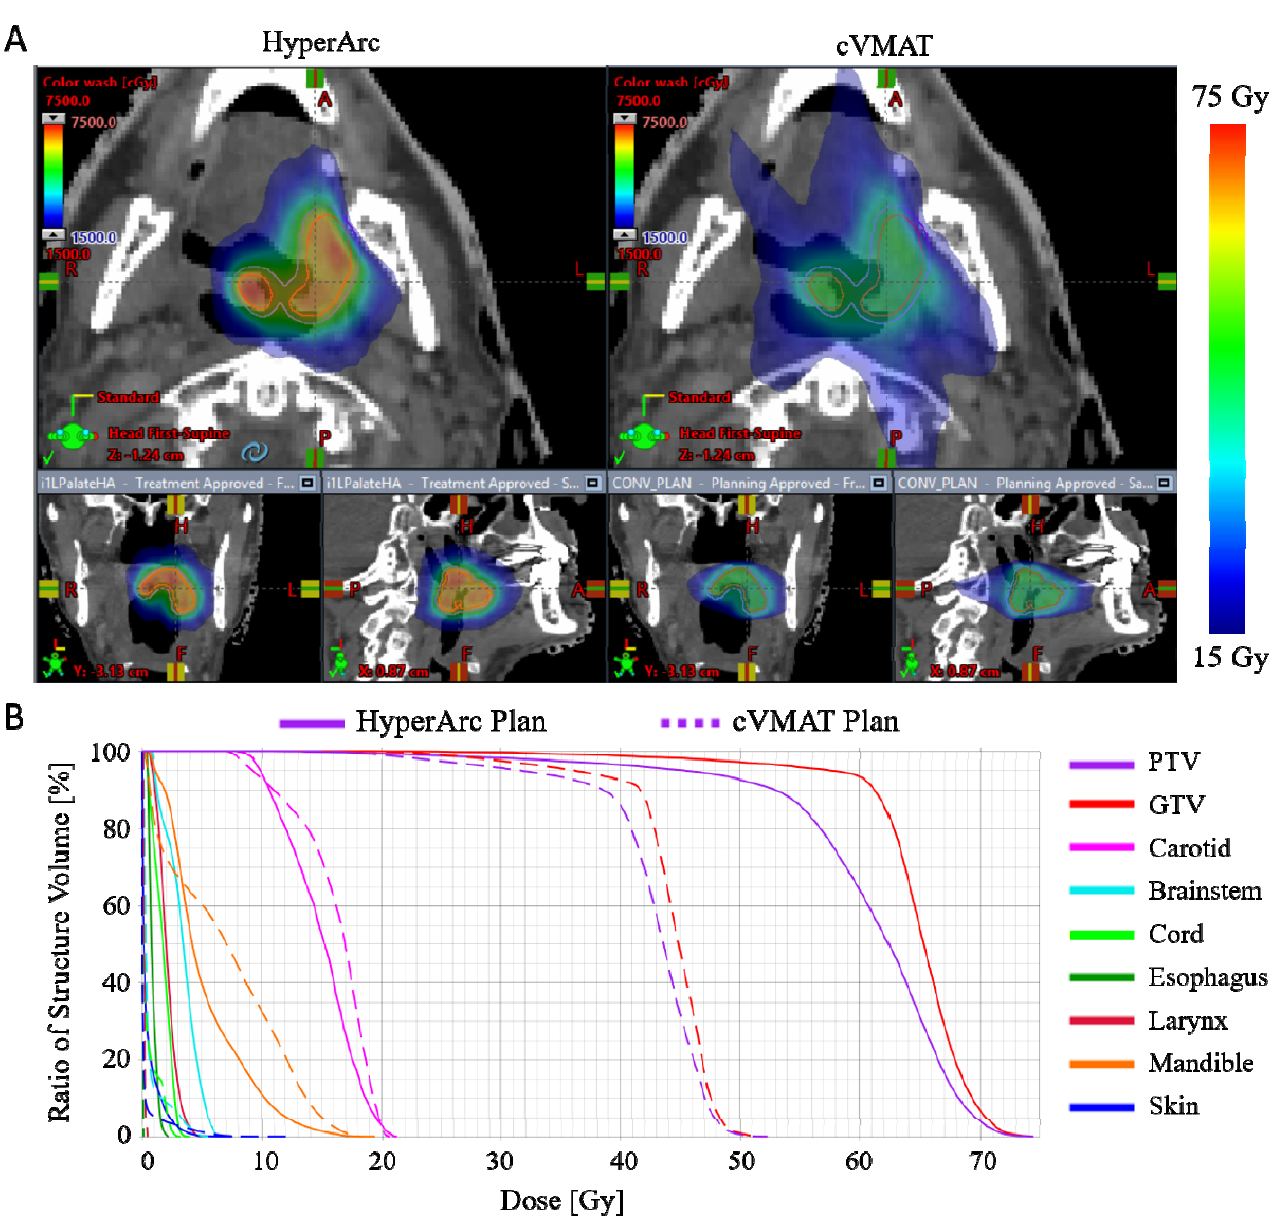
Figure 2. Dose comparison between HyperArc and cVMAT plans for one representative patient in the study (Patient 12). ( A ) Isodose distributions in color wash (GTV shown in orange and PTV shown in blue); ( B ) Dose volume histograms for the HyperArc (solid line) and cVMAT (dashed line) plans.